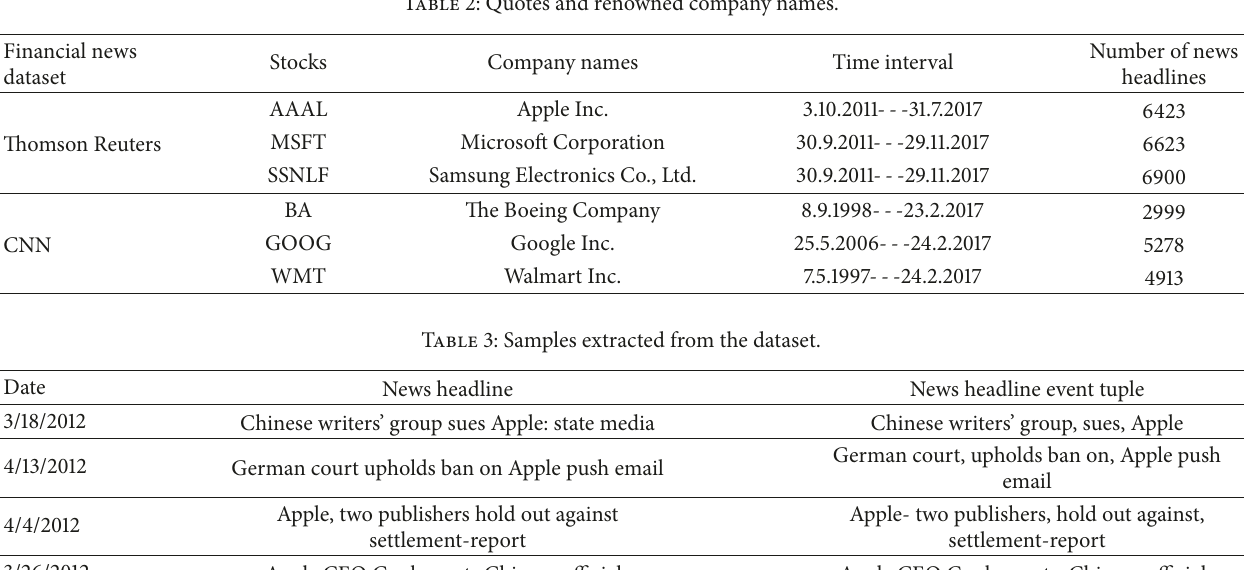
Table 2: Quotes and renowned company names.